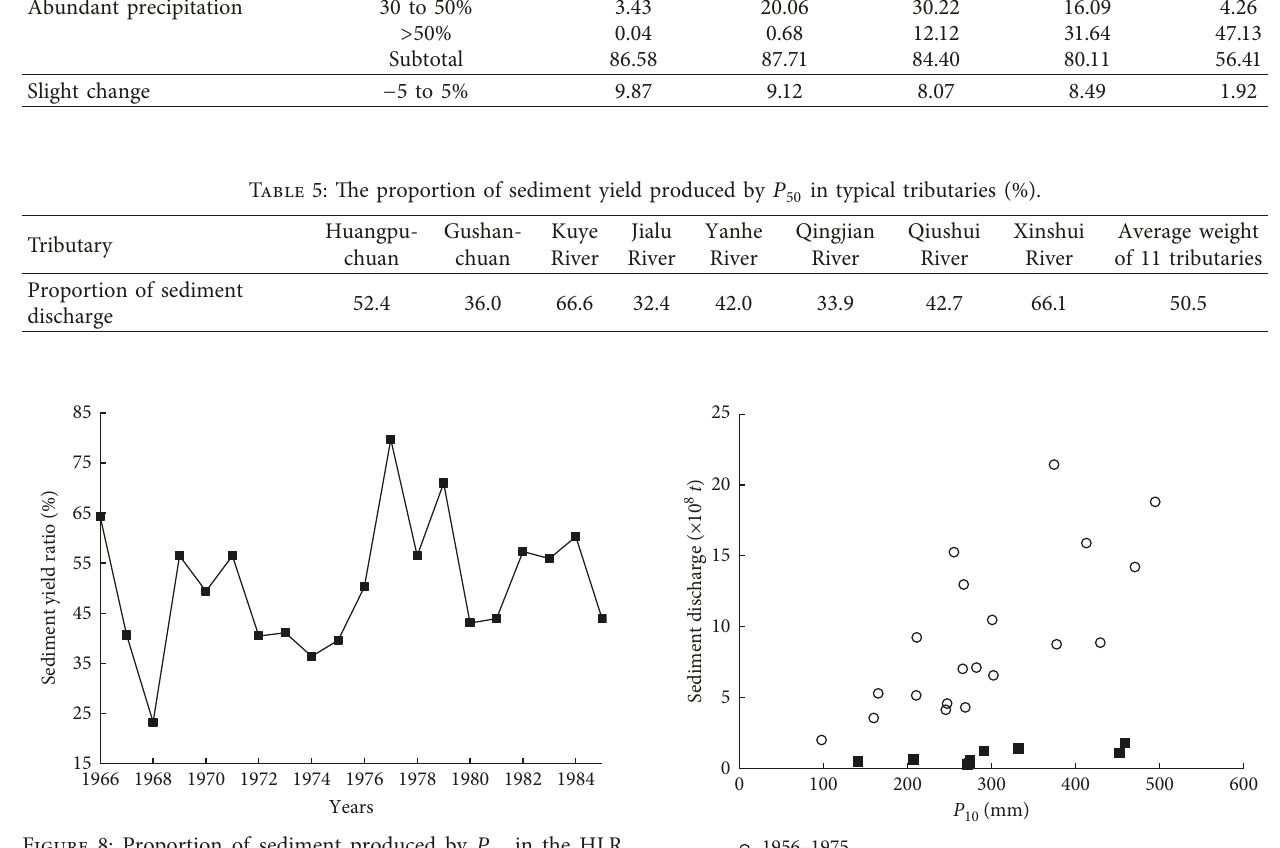
50 in the HLR Figure 9: Relationship between rainfall and sediment yield in two periods in the